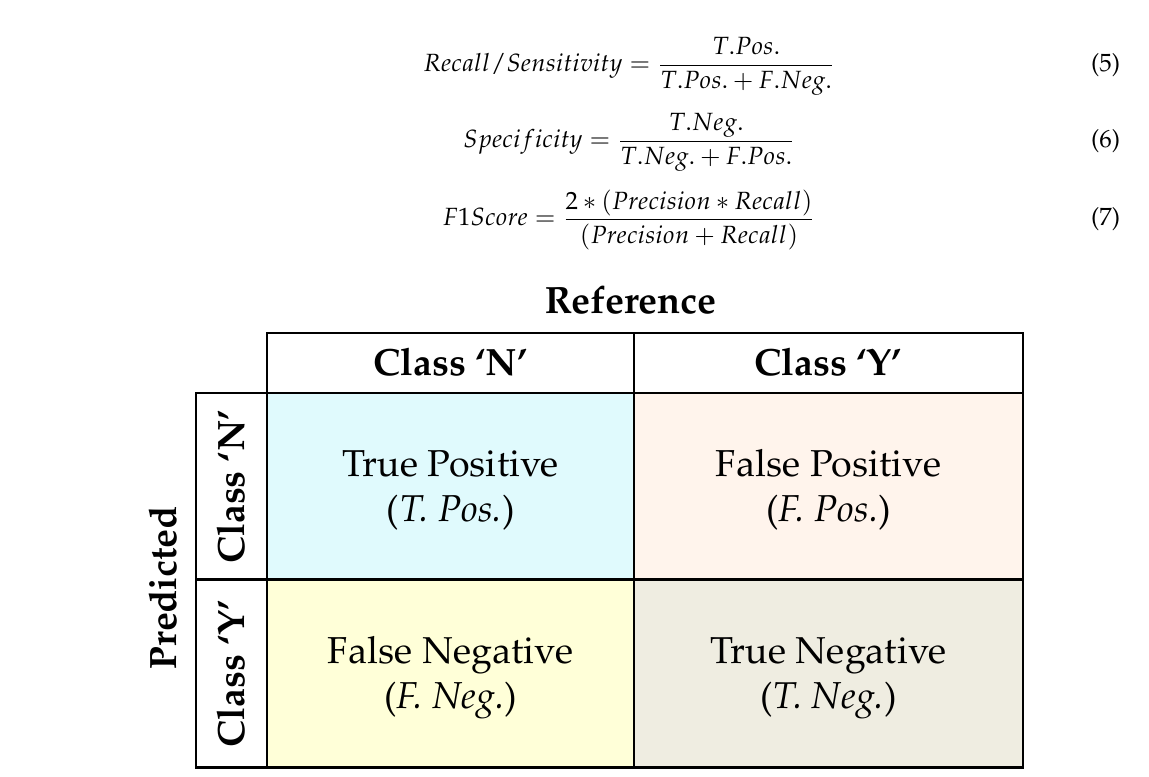
Figure 3. Confusion matrix.